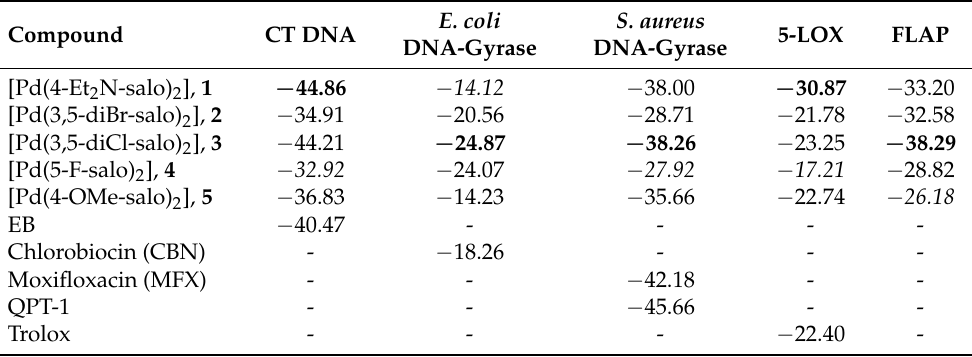
Table 7. ∆ G bind Glide Standard Precision (SP) binding energies (in kcal/mol) of Pd(II) complexes 1 – 5 docked on CT DNA (PDB: 1BNA), E. coli DNA-gyrase and S. aureus DNA-gyrase (PDB: 1KZN and 5CDM, respectively), 5-LOX (PDB: 6N2W), and FLAP (PDB: 2Q7M). Values in bold and italic type denote lowest (among complexes) and highest binding energy,